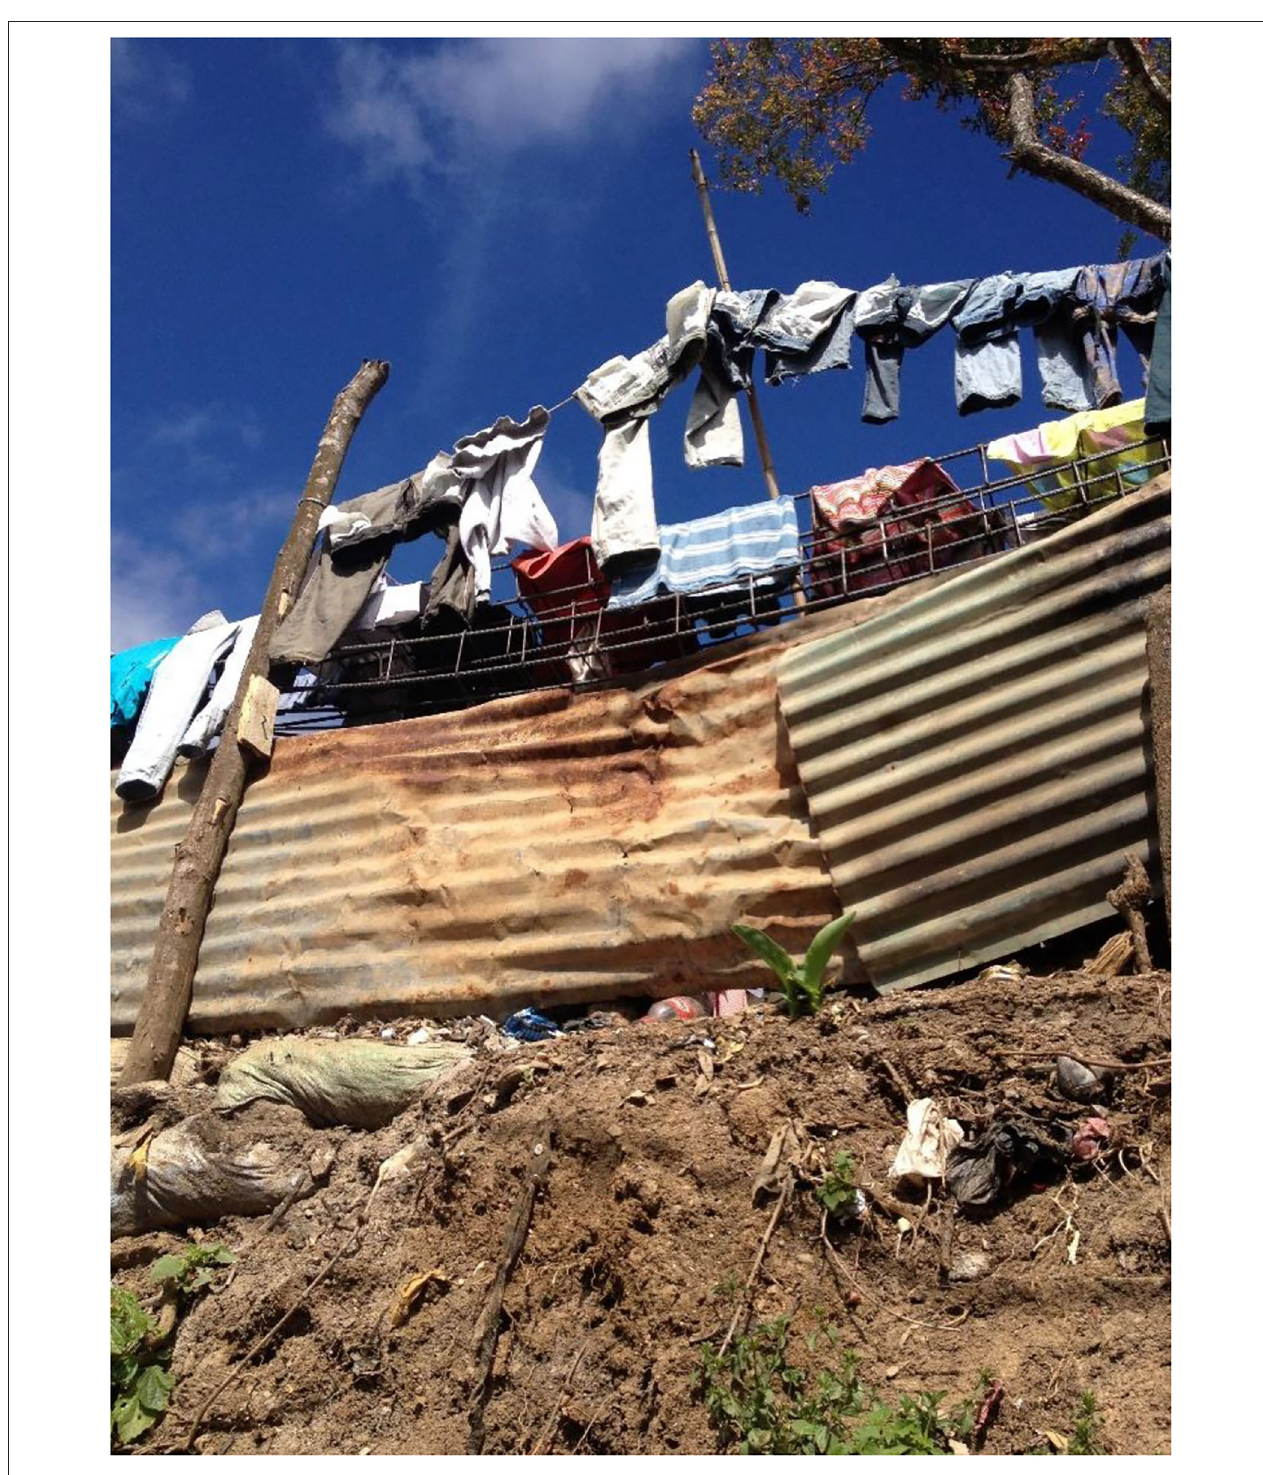
FIGURE 1 | Household living conditions. Source: Authors’